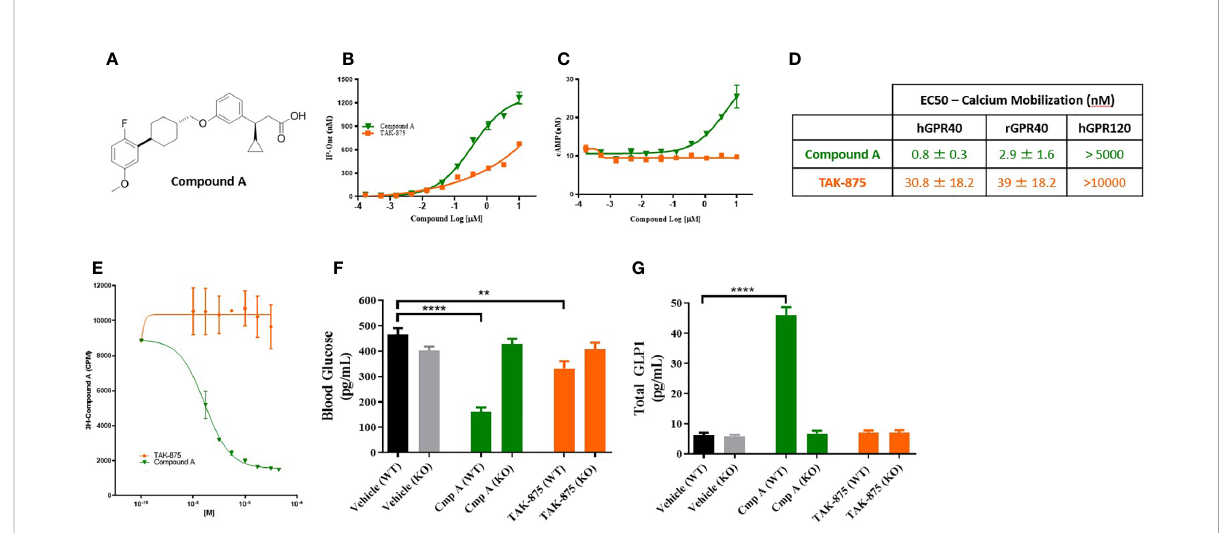
FIGURE 1 Structure and characterization of Compound A. Structure of compound A (A) . Inositol monophosphate and cAMP measurements in GPR40 receptor overexpression CHO cells (B, C) . Summary table of calcium mobilization EC 50 s in overexpressing HEK cells (D) . (E) Competition binding assay where cells are pre-treated with 3H-Compound A then the ability of either a site 1 (TAK-875) or site 3 (cmp A) to compete off hot compound A is assessed. (F, G) Effects of compound A and TAK-875 on blood glucose levels during OGTT and GLP1 secretion in wild-type (WT) and GPR40 knockout mice (KO). Mice were dosed at 100 mg/kg for both compounds. **p<0.01 ****p<.0001 by 1-way ANOVA vs Vehicle